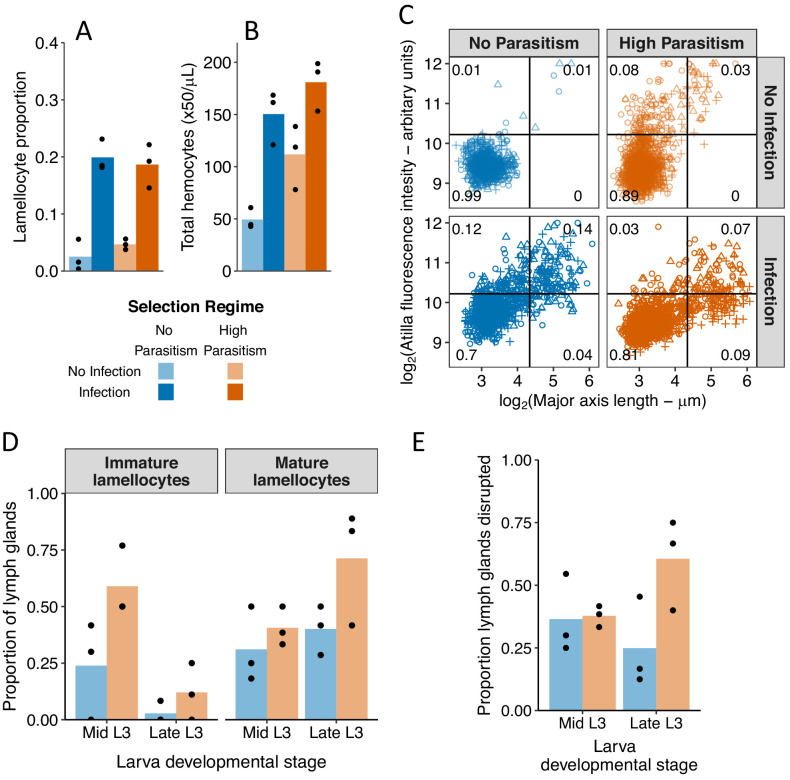
Changes in circulating and lymph gland hemocytes following infection and adaptation to high parasitism rates.(A) The proportion hemocytes that were morphologically identified as lamellocytes and (B) the concentration of total circulating hemocytes in no infection conditions (light colours) and 48 hr post infection (dark colours). Samples were collected from populations that evolved for 34 generation with high parasitism (orange bars) or no parasitism (blue bars) (C) Cell size and atilla expression. The expression of atilla was measured as the fluorescence intensity resulting from immunohistochemistry staining. Cell size was measured along the major axis. Replicated populations from each selection regime are represented by different symbols and the proportion of cells in each quarter of the plot is shown. (D) The proportion of lymph glands from uninfected larvae containing immature lamellocytes (mys+ α-PS4-) and mature lamellocytes (mys+ α-PS4+). (E) Proportion of disrupted lymph glands in uninfected larvae. The lymph gland anterior lobe was considered disrupted when it was either partially or completely disrupted.Figure 5—source data 1.Changes in circulating and lymph gland hemocytes following infection and adaptation to high parasitism rates.